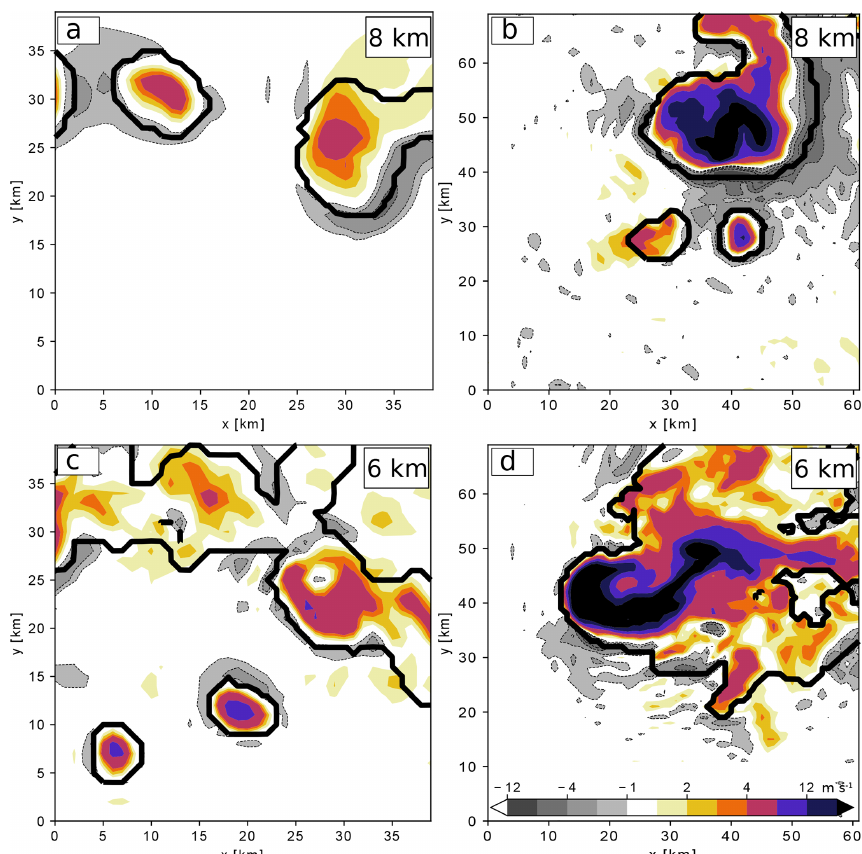
Figure 12. Horizontal cross section of vertical velocities at 6km and 8km height throughout the convective cells displayed in Fig. 11 for (a, c) LR450 and (b, d) HR150, respectively. The black solid line delineates the cloud boundaries (threshold of cloud and ice water contents > 0 . 001gkg − 1